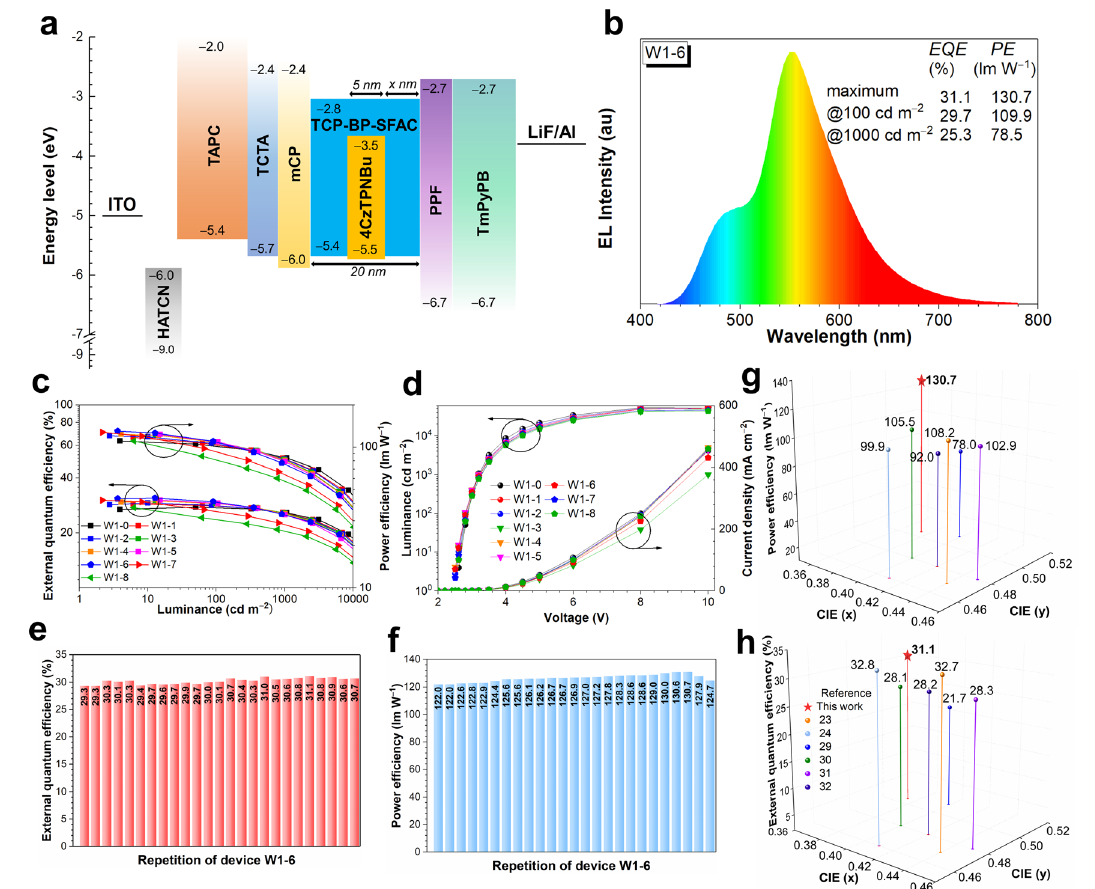
Fig. 2 | Device data and EL performance of two-color WOLEDs. a Device con- fi guration of all- fl uorescence two-color WOLEDs. b EL spectra of device W1-6 at 1000cdm − 2 . c External quantum ef fi ciency-luminance-power ef fi ciency curves of deviceW1-0~W1-8. d Luminance-voltage-currentdensitycurvesofdeviceW1-0 – W1-